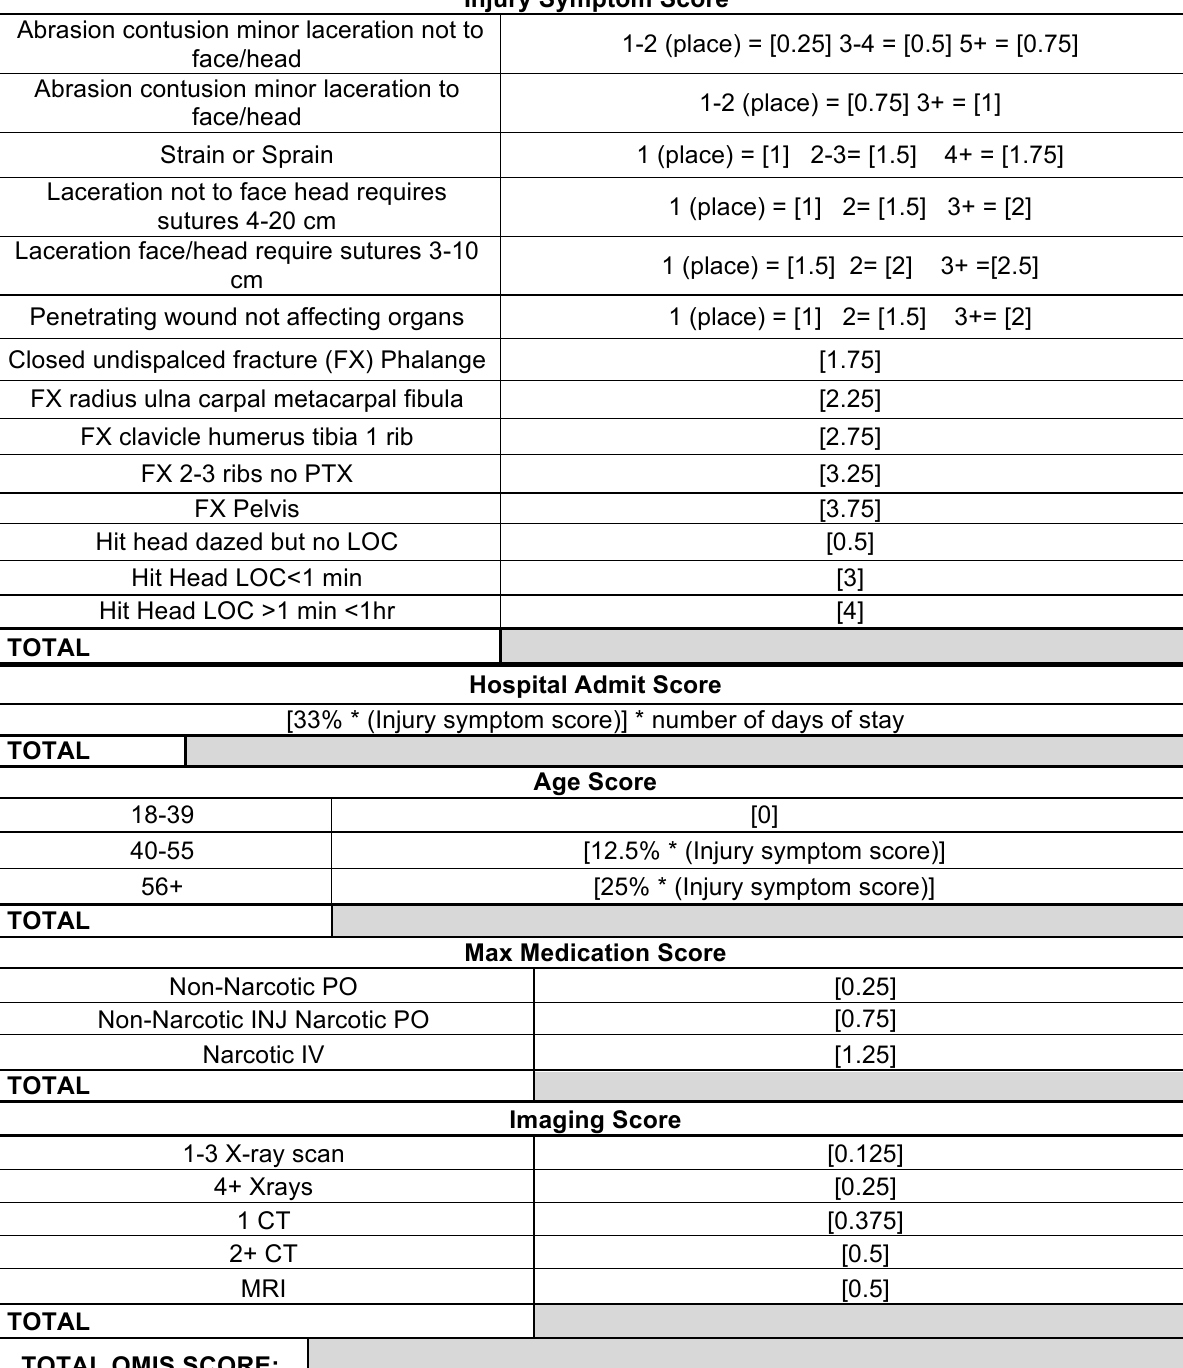
Table 1. QMIS Score